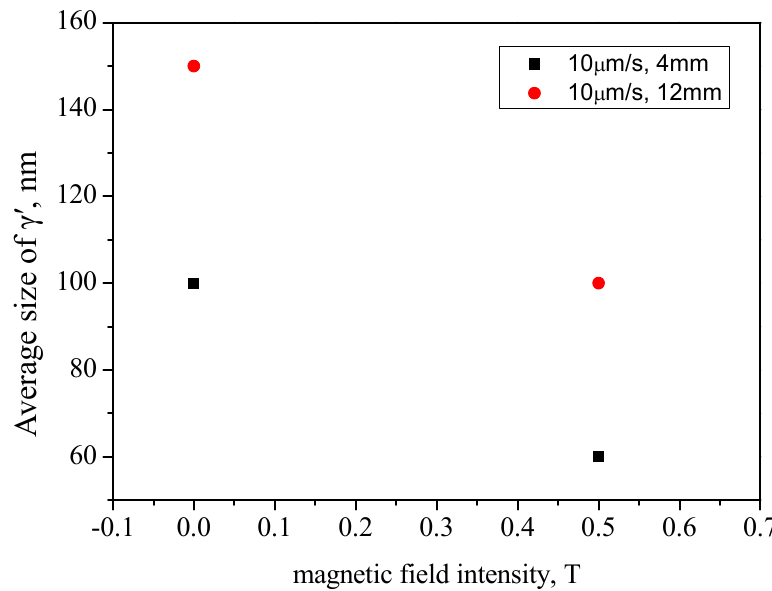
Figure 5. The γ ’ size in the dendrite core of Ni-based specimens with various diameters at a temperature gradient of 80 K·cm − 1 .